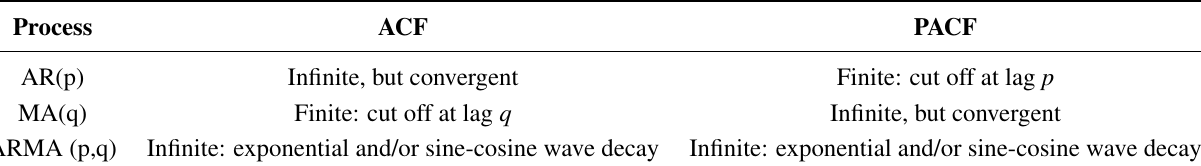
Table 3. Autocorrelation patterns of autoregressive integrated moving average (ARIMA) models.